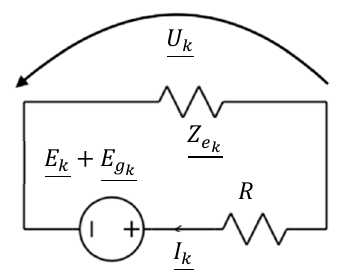
Figure 4. Equivalent circuit for harmonic k .